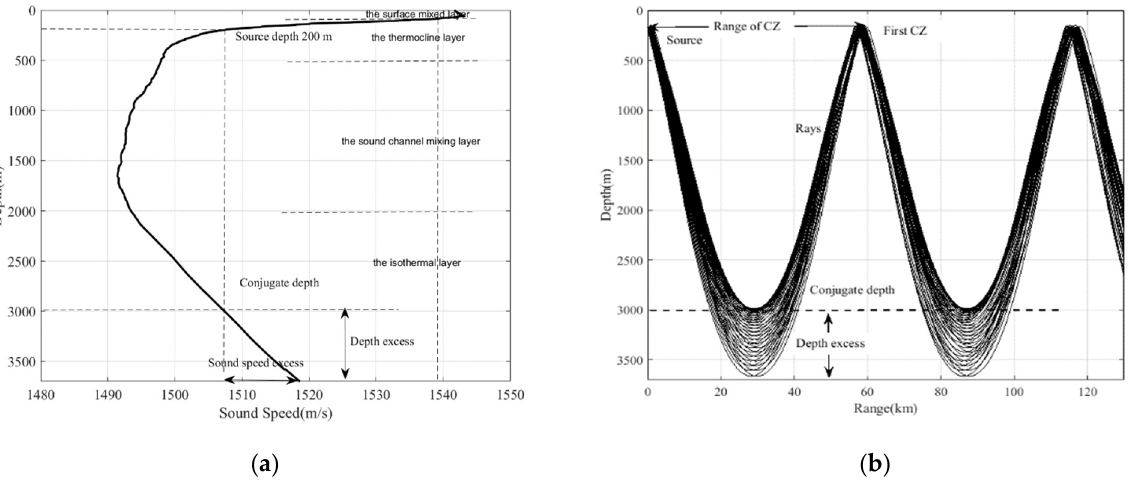
Figure 7. The stratification of the sound speed profile at depth ( a ) and the sound rays ( b ) in the EIO. When a source is close to the surface, according to the Snell law, the sound rays bend toward the vertical. In other words, the sound rays emitted by the source will bend to the bottom. The sound rays will gradually bend toward the surface after passing through the sound channel axis where the sound speed is minimum, where sound speed increases with depth in the deep isothermal layer because of the increase in pressure. When the sound speed near the bottom is greater than that close to the source, some sound rays with small grazing angles do not touch the bottom and reverse upward near conjugate depth. After this process, sound rays converge at the surface to form a